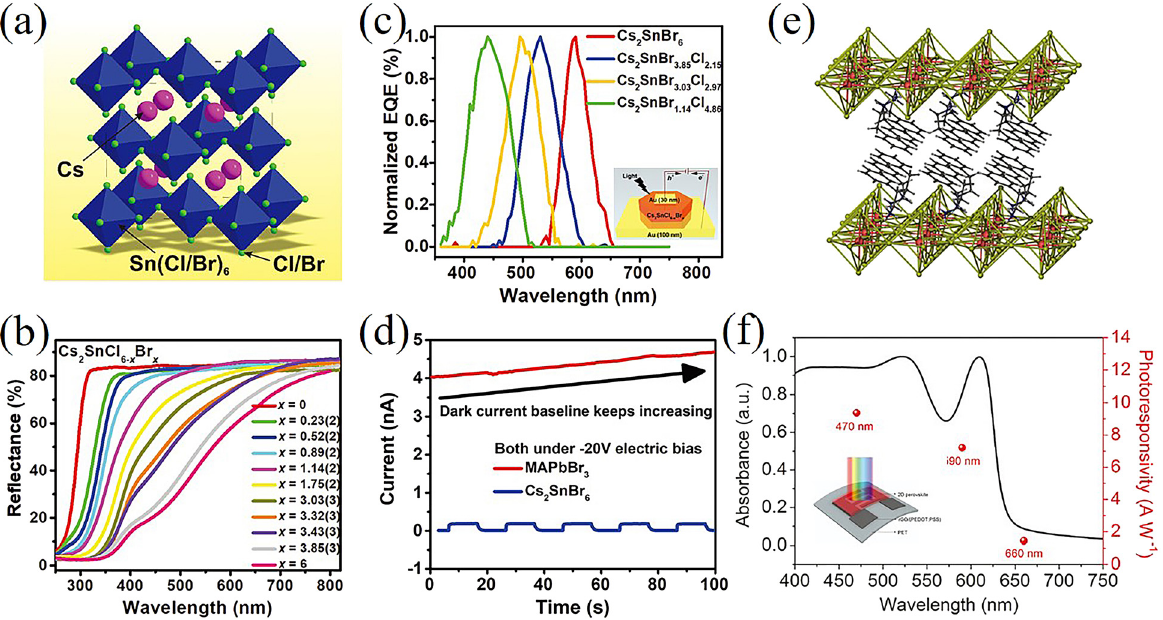
Figure 3: Tin perovskite variants-based visible photodetectors. (a) Schematic view of the Cs 2 SnCl 6 − x Br x crystal structure by discrete [Sn(Cl, Br) 6 ] 2 − octahedra, which are caused by the missing of Sn atoms. (b) Composition-dependent UV – vis. diffuse re fl ectance spectra of Cs 2 SnCl 6 − x Br x ( x = 0 – 6). (c) Normalized EQE spectra of Cs 2 Sn(Br, Cl) 6 single crystal-based photodetectors measuredundera − 20 V bias. Inset:schematicdiagramof thedevice con fi guration.(d) Darkcurrent drift testof a Cs 2 SnBr 6 (1.3 mm in thickness) crystal in comparison to a MAPbBr 3 crystal (1.4 mm in thickness) measured under a constant − 20 V electric bias.Reproducedwithpermission.Copyright2019,Wiley-VCHVerlag[73].(e)Schematicdiagramofthe2Dlayered(PEA) 2 SnI 4 crystalstructure (orange balls for tin atoms; yellow balls for iodine atoms; blue balls for nitrogen atoms; dark grey balls for carbon atoms; light grey balls for hydrogenatoms).(f)Absorptionspectrumoftheperovskite fi lm(with30mol%SnF 2 )andthewavelength-dependentphotoresponsivityat470, 590 and 660 nm (130 μ W cm − 2 irradiance, 5 V bias). Inset: Schematic view of the (PEA) 2 SnI 4 -based fl exible photodetector. Reproduced with permission. Copyright 2018, Royal Society of Chemistry